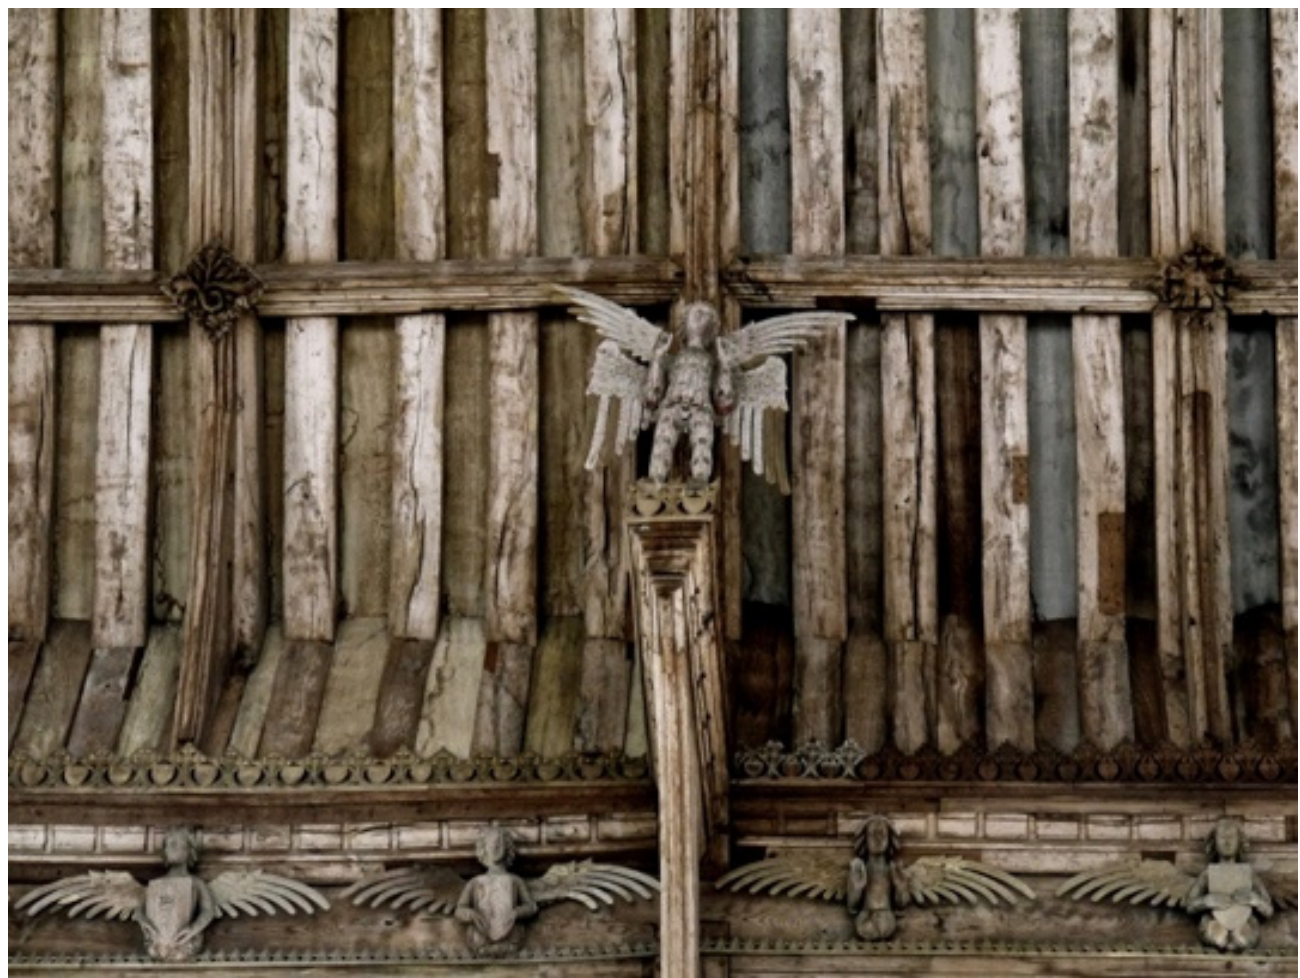
Figure 3. Roof angel at St Agnes at Cawston.